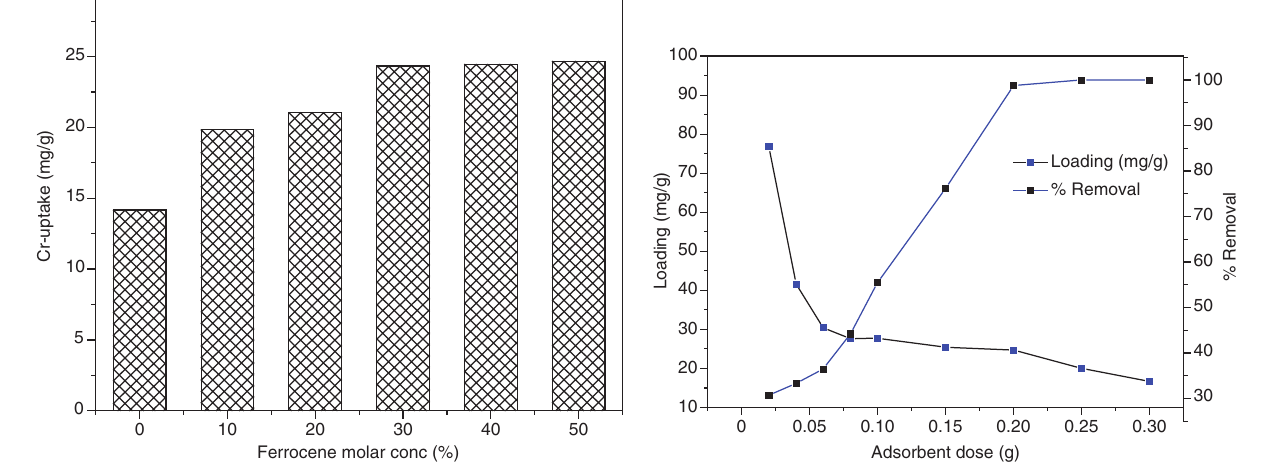
Figure 7 Effect of adsorbent dose on the adsorption of Cr(VI) (initial concentration = 100 mg/l, temperature = 30 ° C, time = 24